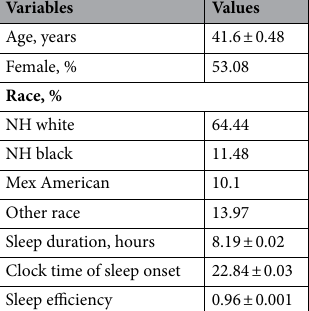
Clock time of sleep onset